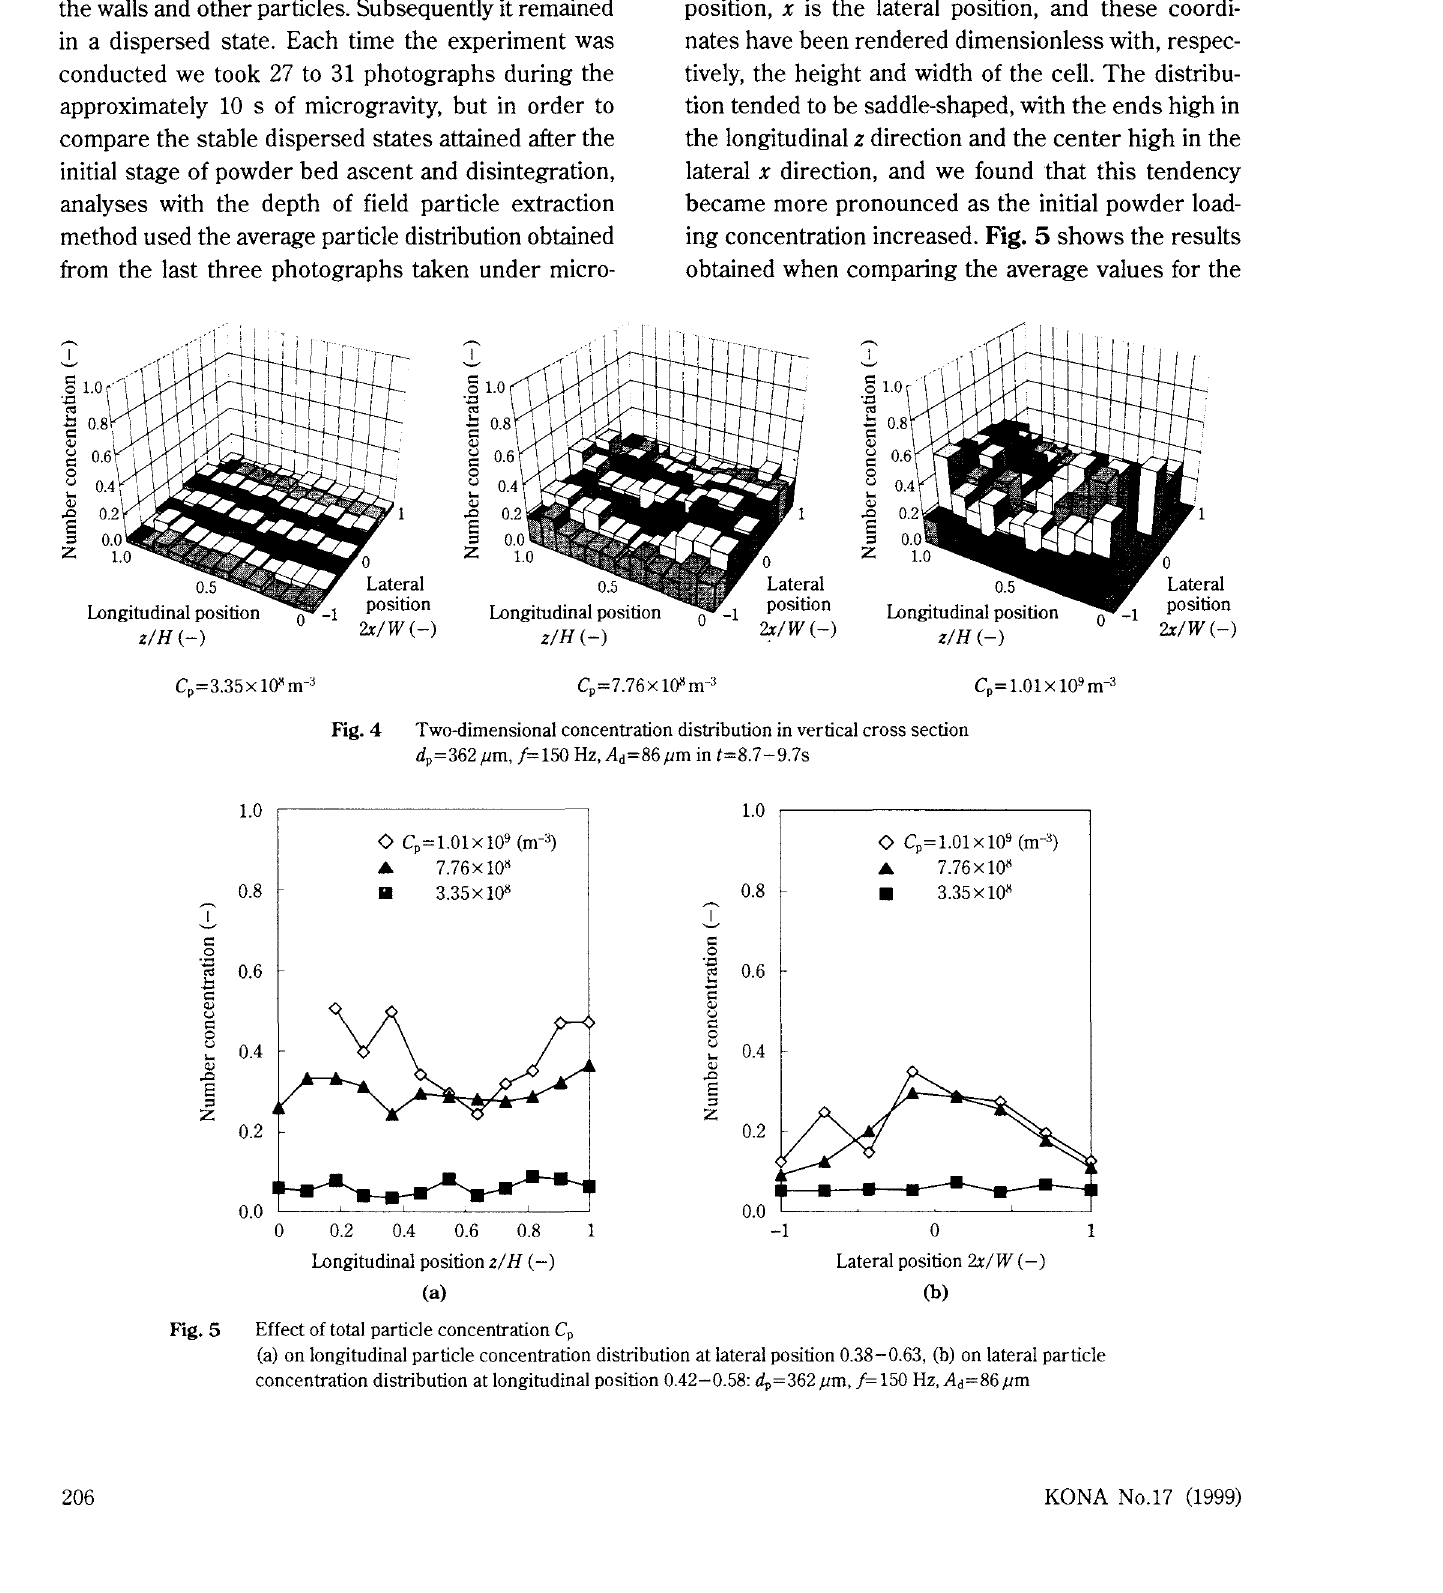
Fig. 5 Effect of total particle concentration Cp (a) on longitudinal particle concentration distribution at lateral position 0.38-0.63, (b) on lateral particle concentration distribution at longitudinal position 0.42-0.58: dp=362 .urn,/= 150Hz, Ad=86